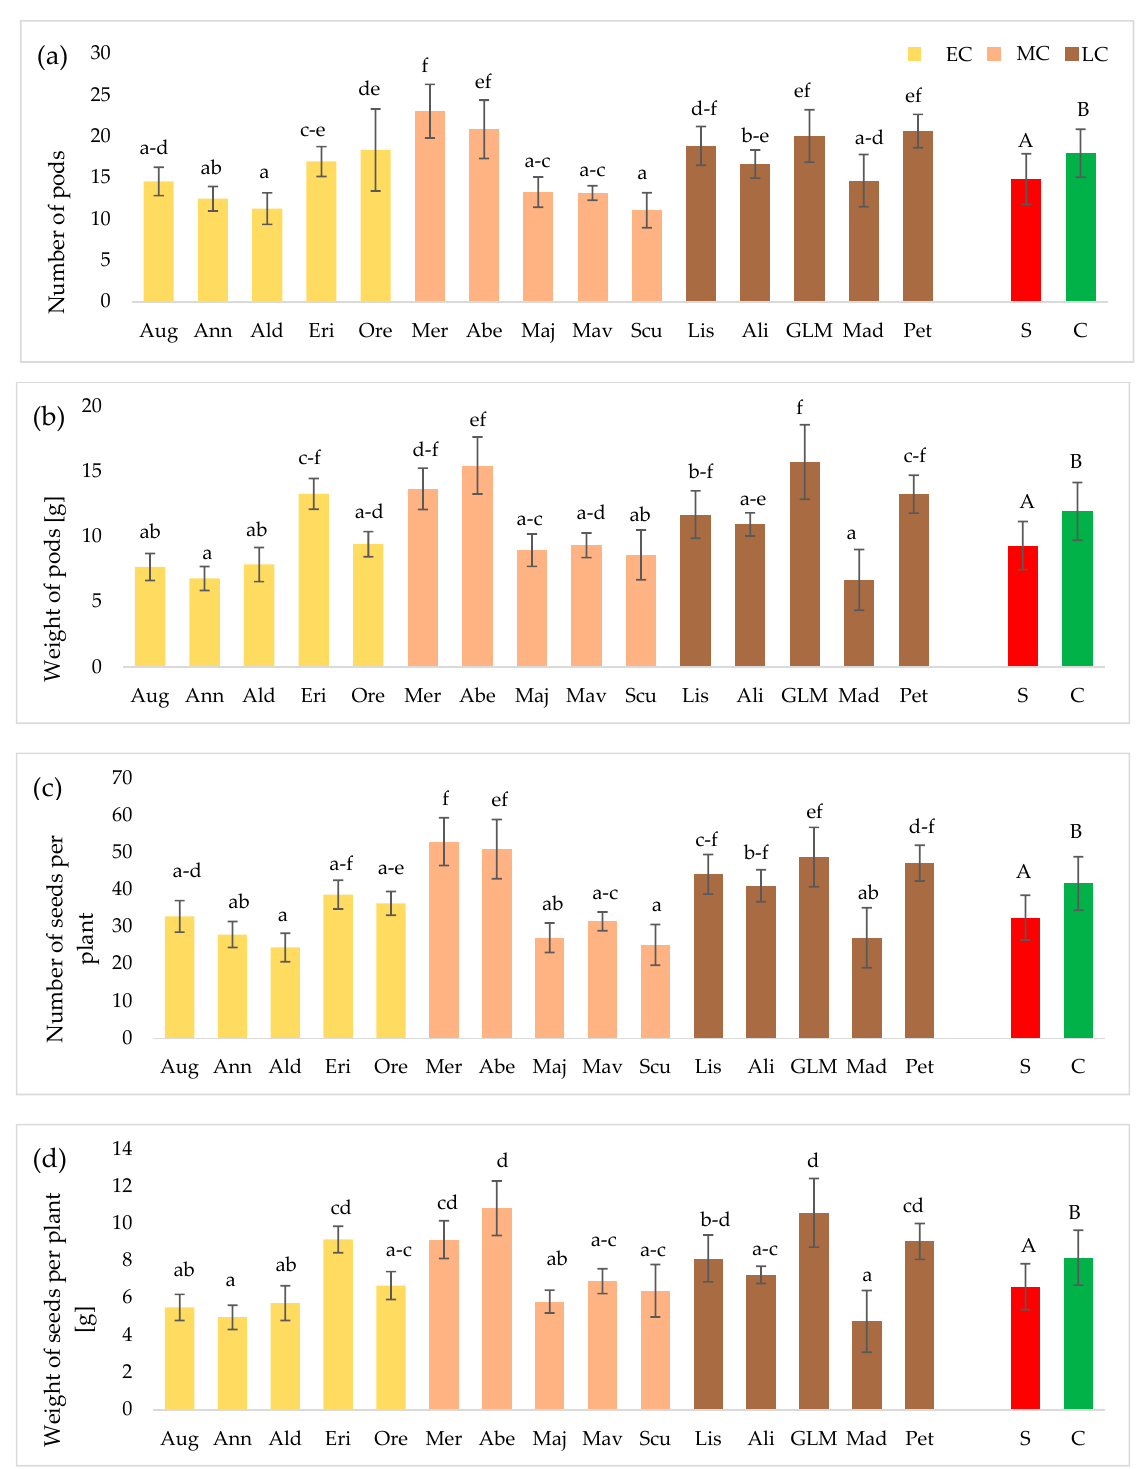
Figure 1. The effects of cold stress (n = 150) and cultivar (n = 20) treatments on the plant structure: plant height ( a ), height to the first pod ( b ), number of nodes ( c ), stem dry mass ( d ). Cultivars: Augusta (Aug), Annushka (Ann), Aldana (Ald), Erica (Eri), Oressa (Ore), Merlin (Mer), Abelina (Abe), Maja (Maj), Mavka (Mav), Sculptor (Scu), Lissabon (Lis), Aligator (Ali), GL Melanie (GLM), Madlen (Mad), Petrina (Pet); EC—very early and early cultivars, MC—medium–early cultivars, LC—late and very late cultivars Different lowercase letters indicate significant difference between cultivars, different uppercase letters—between treatment (cold stress (S) and control (C)) according to the Tukey test ( p = 0.05); ±SD.